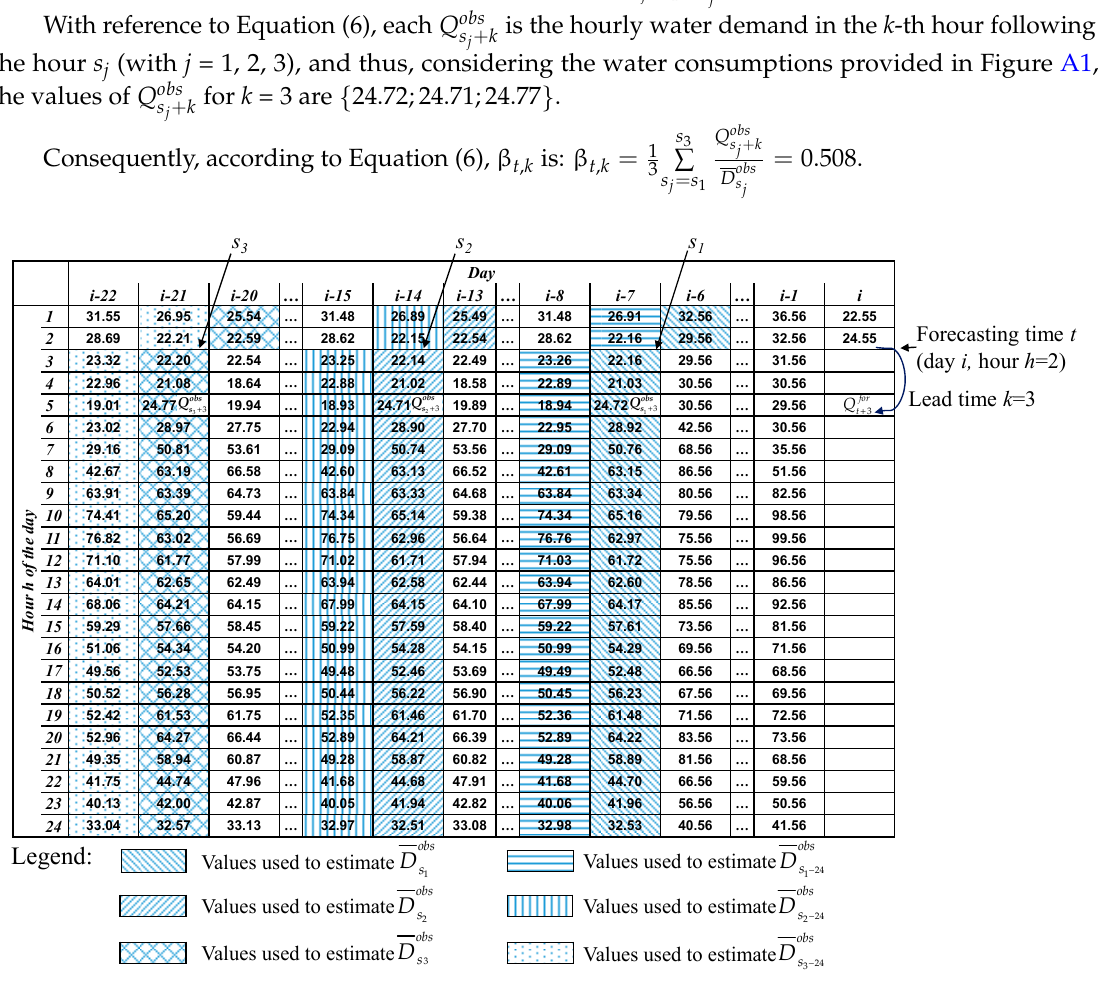
Figure A1. Hourly water consumption of the days { i , i − 1, . . . , i − 6, i − 7, i − 8, . . . , i − 13, i − 14, i − 15, . . . , i − 20, i − 21, i − 22}. The values used to compute α t and β t , k at the forecasting time t considering a lead time k = 3 are highlighted using the halftone screens provided in the legend.